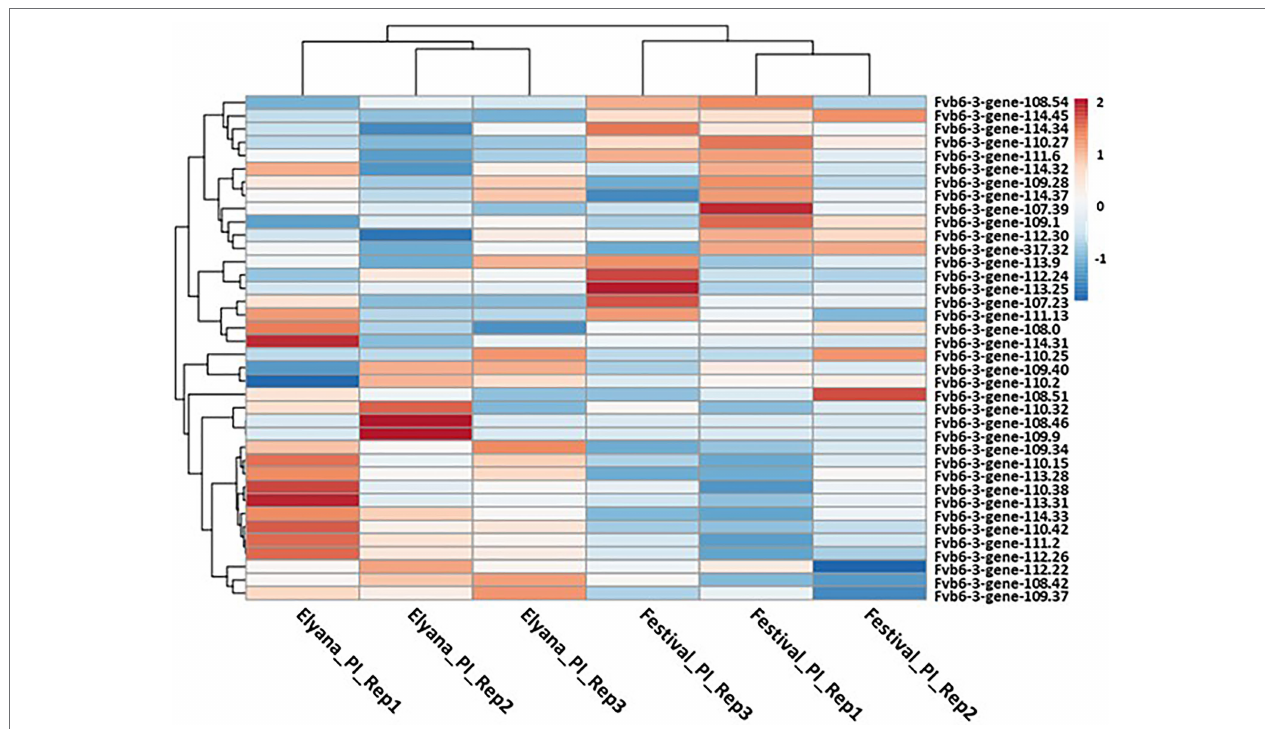
FIGURE 4 | Heatmap representation of the genes that lie within the FaRCg1 region. The normalized log2 transformed fold change of the expression value lying within the resistance locus due to C. gloeosporioides infection is indicated by a color scale comprising of brown (upregulated) and blue (downregulated). Each row represents a gene. A total of 38 genes were considered for this